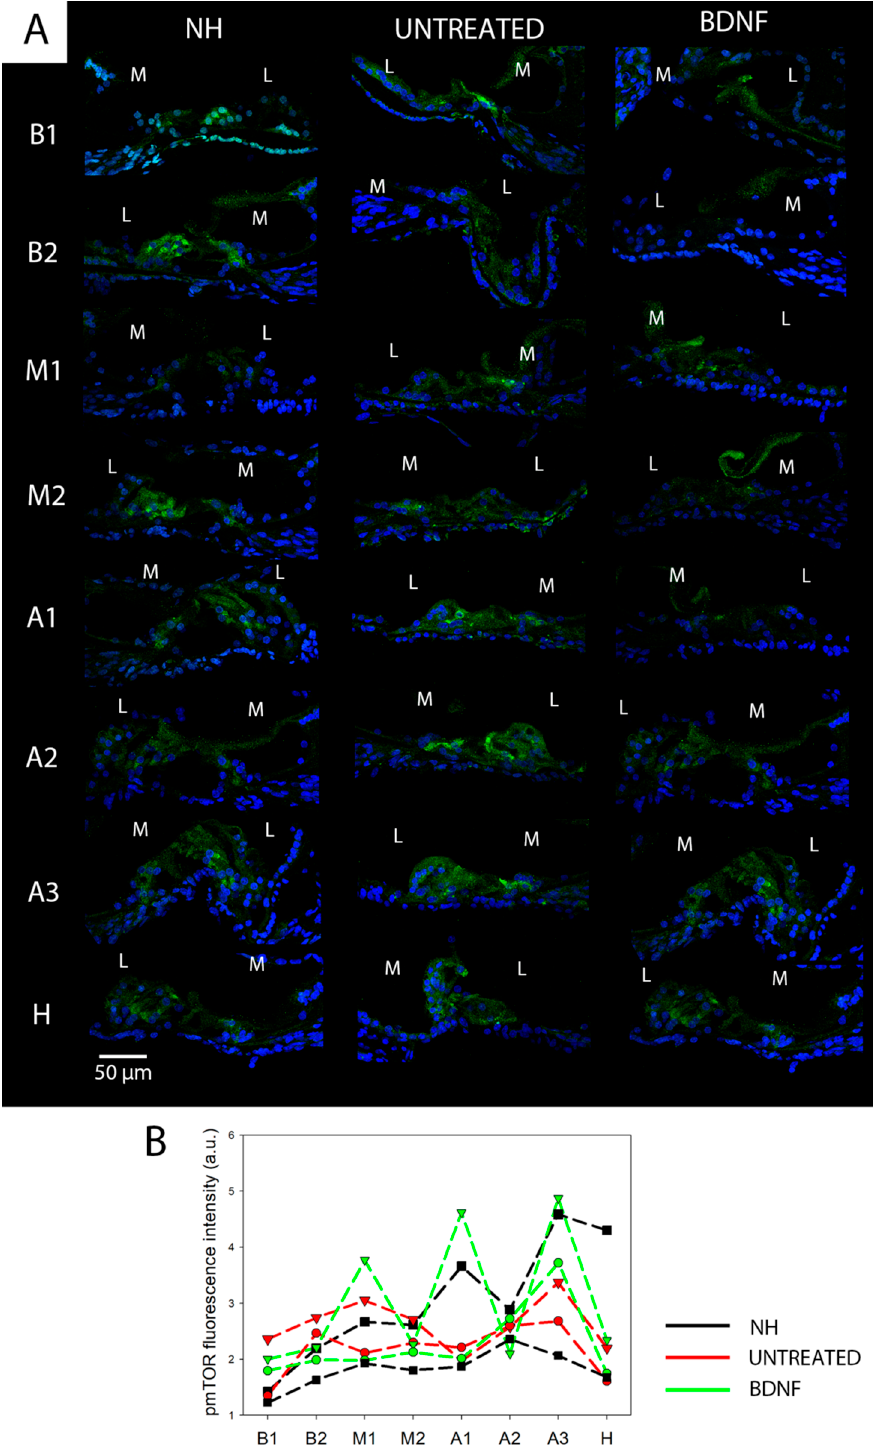
Figure 8. Immunolocalization and fluorescence intensity of pmTOR. ( A ) Representative confocal images showing the organ of Corti immunolabelled with anti-pmTOR (green) and counterstained with bisbenzimide nuclear dye (blue) of all experimental groups and for each cochlear location (from B1 to H). Scale bar: 50 µm. L: lateral, M: medial. ( B ) Fluorescence intensity analysis of pmTOR immunostaining. The graph shows the signal intensity of each sample for all cochlear locations (black: NH, red: untreated, green: BDNF-treated). The same symbol was used to identify the BDNF-treated and untreated ears of individual animals.